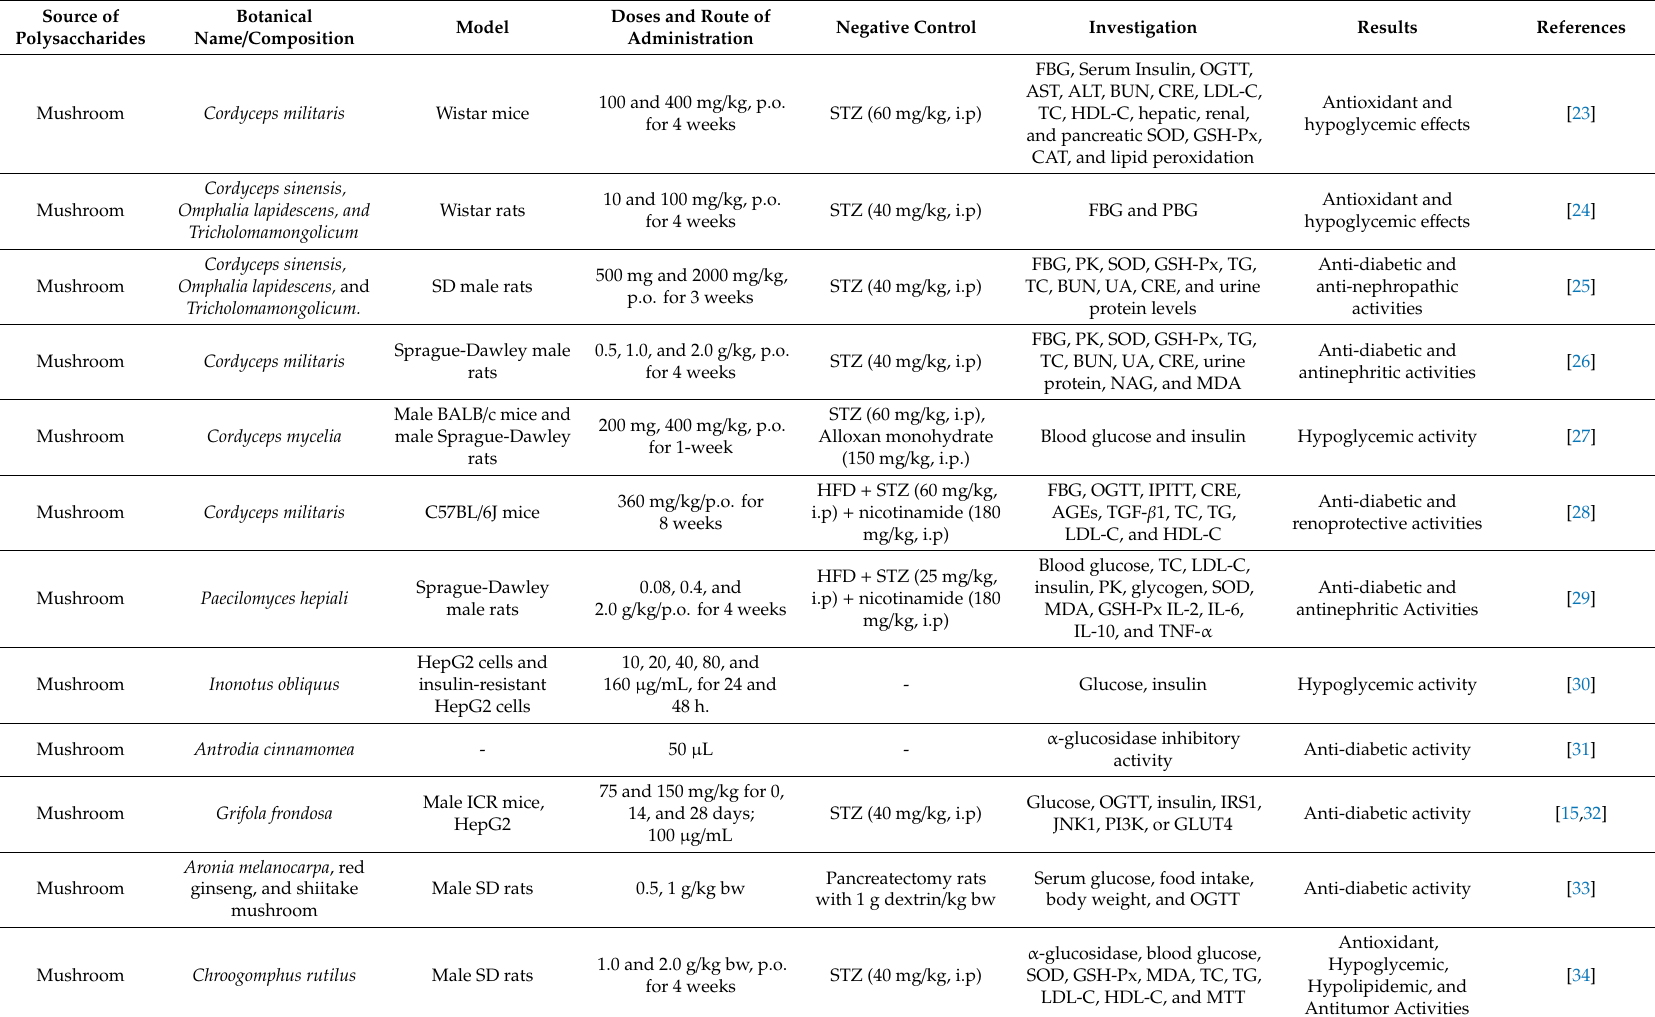
Table 1. In vitro and in vivo actions of dietary polysaccharides and their anti-diabetic